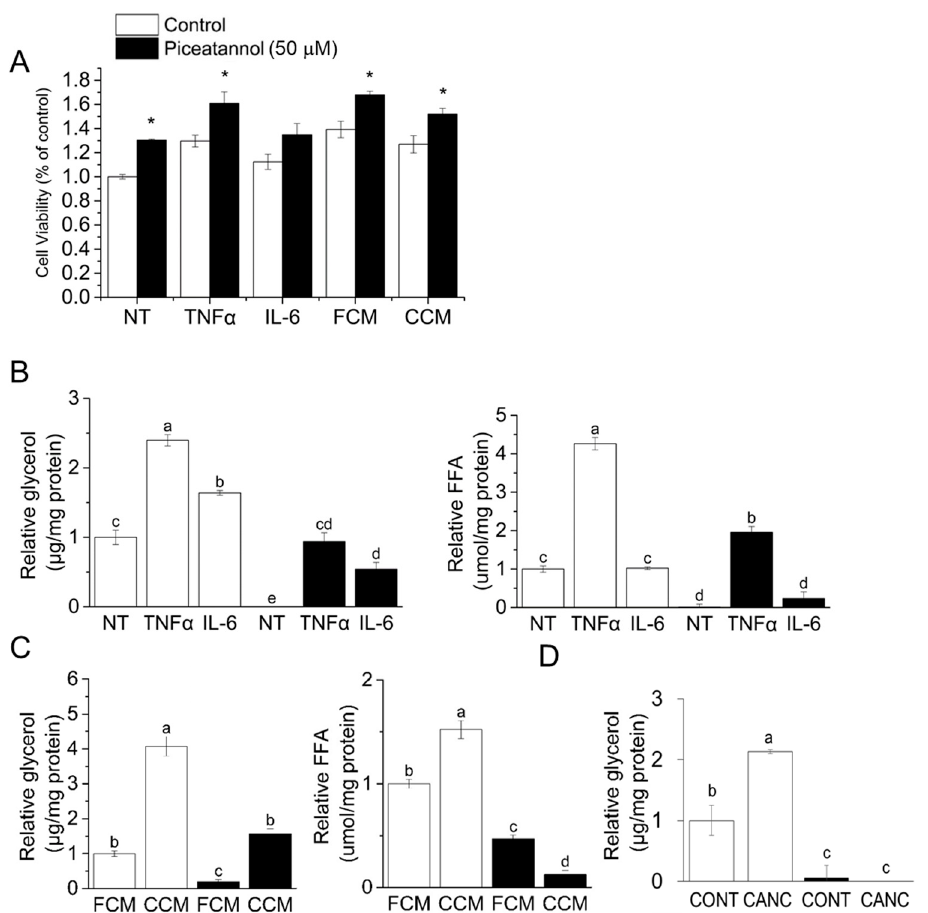
Figure 2. Piceatannol prevents cancer-associated lipolysis. ( A ) Mature 3T3-L1 adipocytes treated with cancer-associated stimuli in the presence or absence of 50 µ M piceatannol were subjected to the thiazolyl blue tetrazolium bromide (MTT) assay. Mature 3T3-L1 adipocytes were subjected to ( B ) Tumor necrosis factor alpha (TNF- α ) or interleukin -6 (IL-6), ( C ) fibroblast- or cancer-conditioned media, or ( D ) co-culture with either non-transformed human duct epithelial pancreatic cells (HPDE6) (CONT) or AsPC-1 pancreatic cancer cells (CANC) in the absence or presence of piceatannol (50 µ M) for 3 h. In A-C, 8-h co-treatment with piceatannol treatment followed 16-h stimuli only treatment. Glycerol and free fatty acids (FFA) in the media were measured as markers of lipolysis, n = 3/group. All data presented were mean ± S.E.M. Treatments with different letters are statistically different ( p < 0.05, Tukey’s post-hoc test following ANOVA). Where only two treatments were analyzed, p values were calculated using Student’s t-test. * p < 0.05.